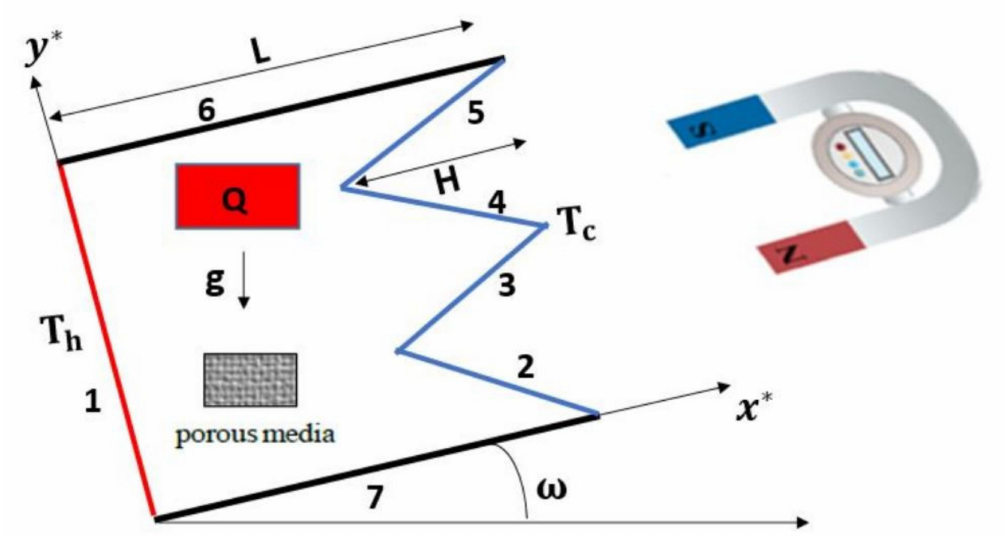
Figure 1. A schematic diagram of the physical model